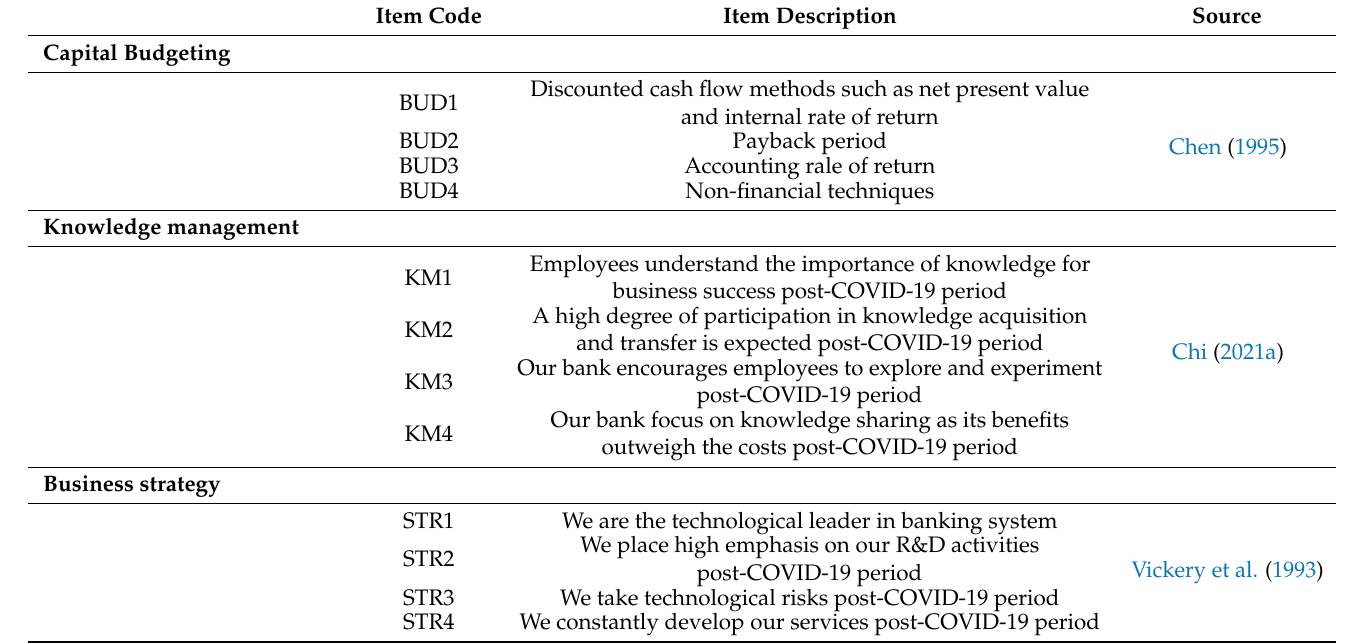
Table 1. Measurement